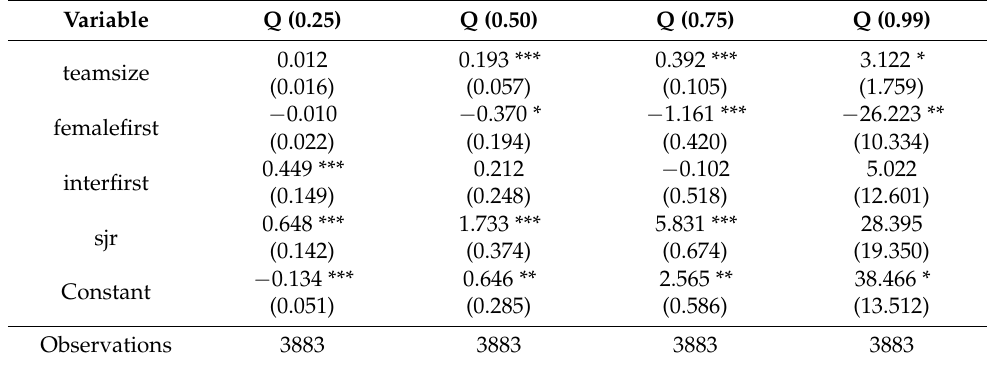
Table 8. Estimating a quantile regression across the distribution of